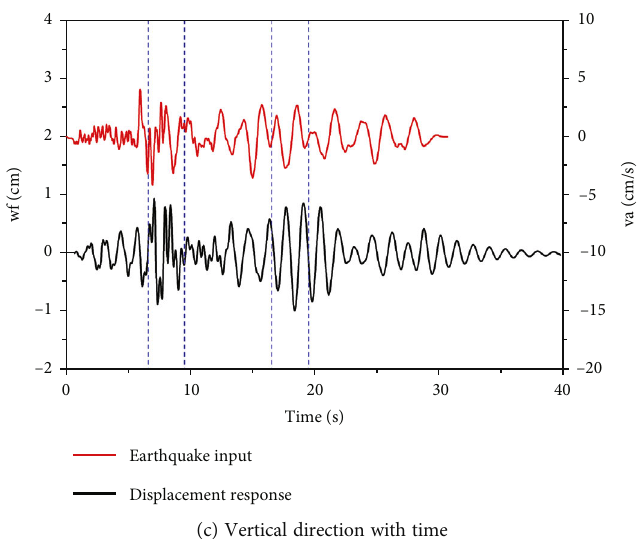
Figure 3: Displacement of the top of the arch during near-fault ground motion with time.